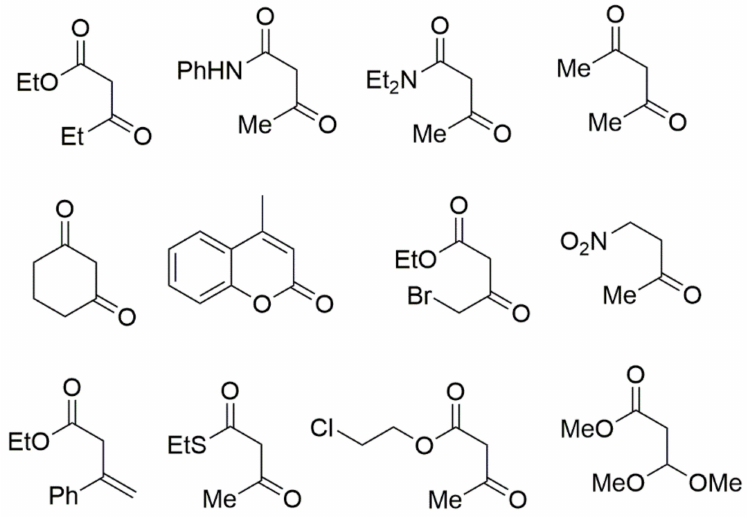
Figure 6. Typical CH-acidic carbonyl building blocks employed in Biginelli